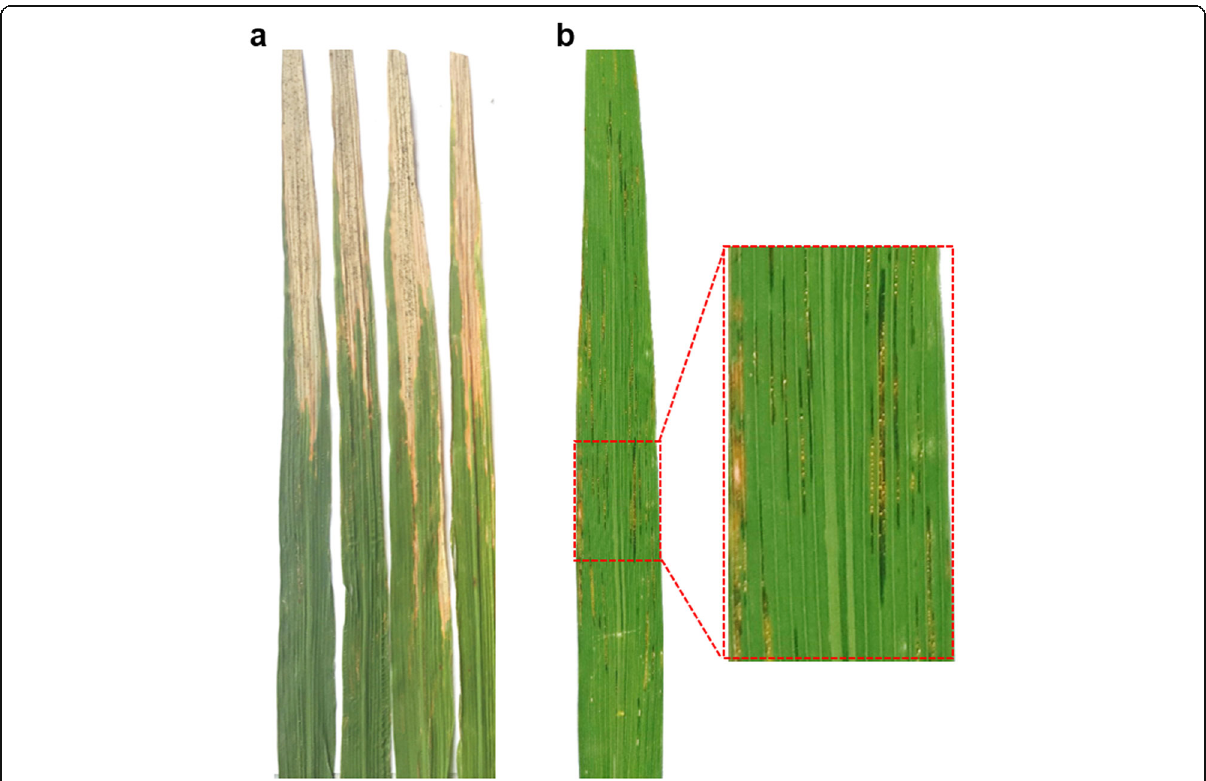
Fig. 1 Symptoms of ( a ) bacterial light caused by Xanthomonas oryzae pv. oryzae and ( b ) bacterial leaf streak caused by Xanthomonas oryzae pv. oryzicola